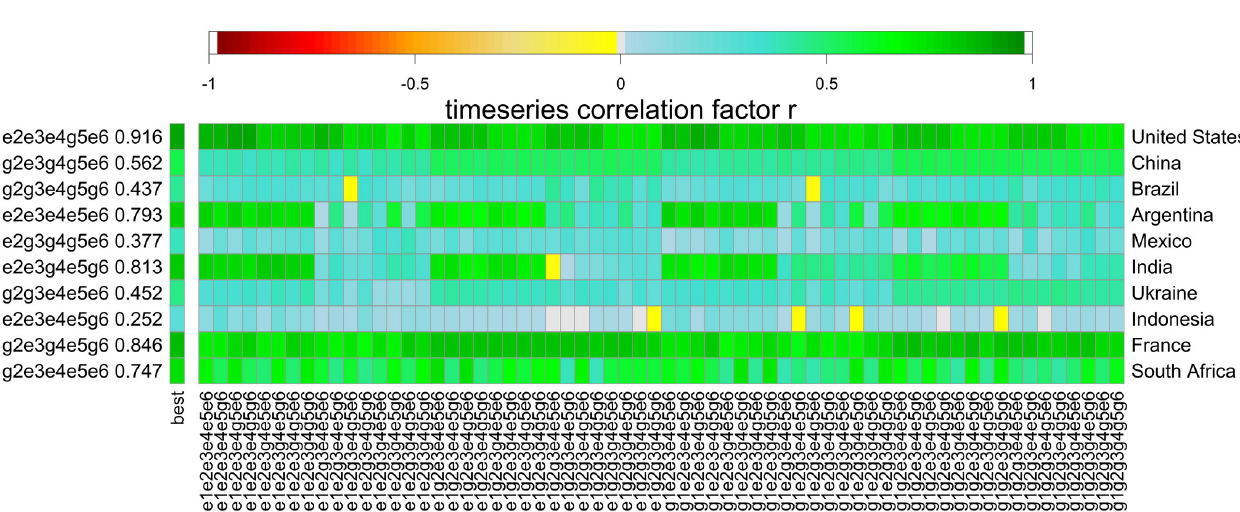
PLOS ONE | https://doi.org/10.1371/journal.pone.0221862 September 16,